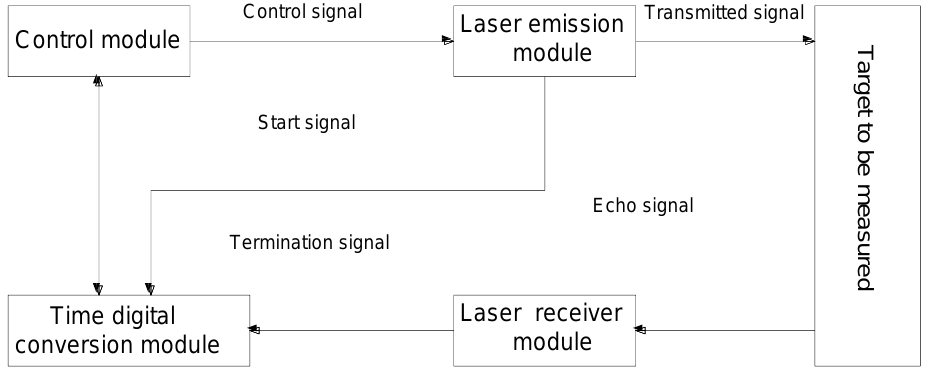
Figure 2. Schematic diagram of the pulsed laser ranging system.